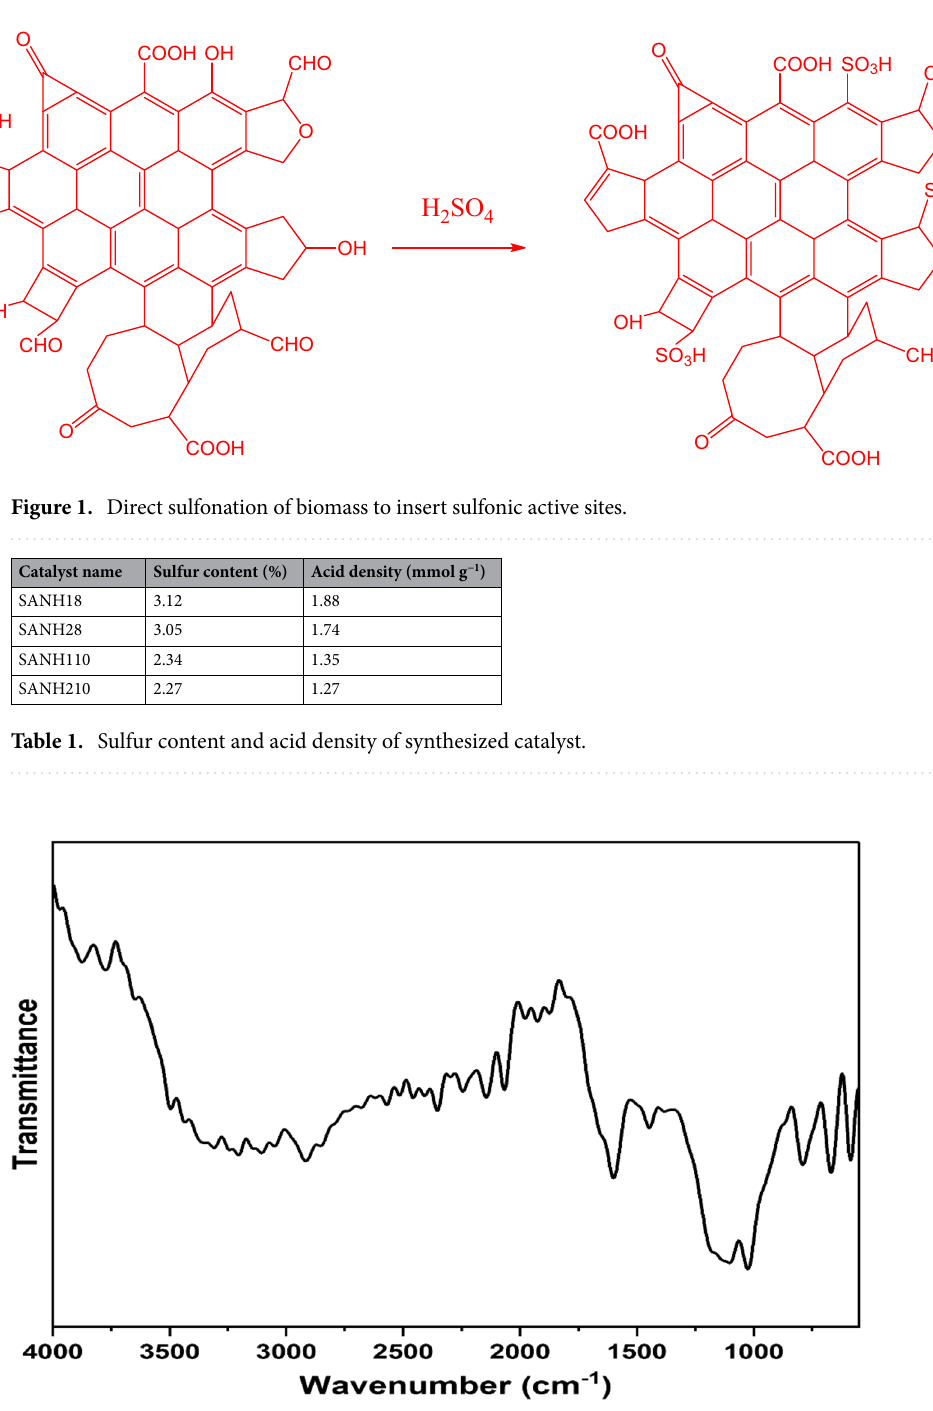
Figure 2. FTIR spectrum of SANH18